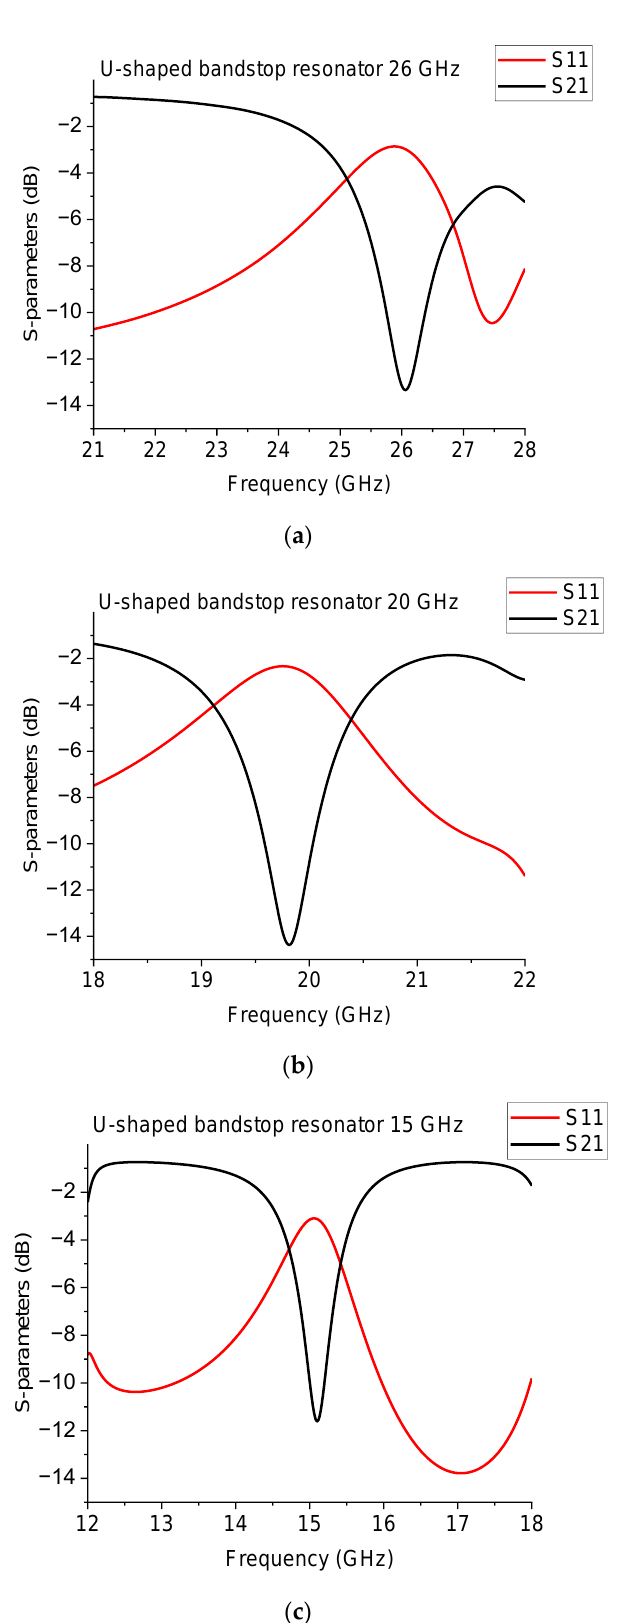
Figure 2. Simulated response for the U-shaped resonators, working approximately around ( a ) 26 GHz, ( b ) 20 GHz, and ( c ) 15 GHz. S 11 is the reflection parameter, while S 21 is the transmission parameter.